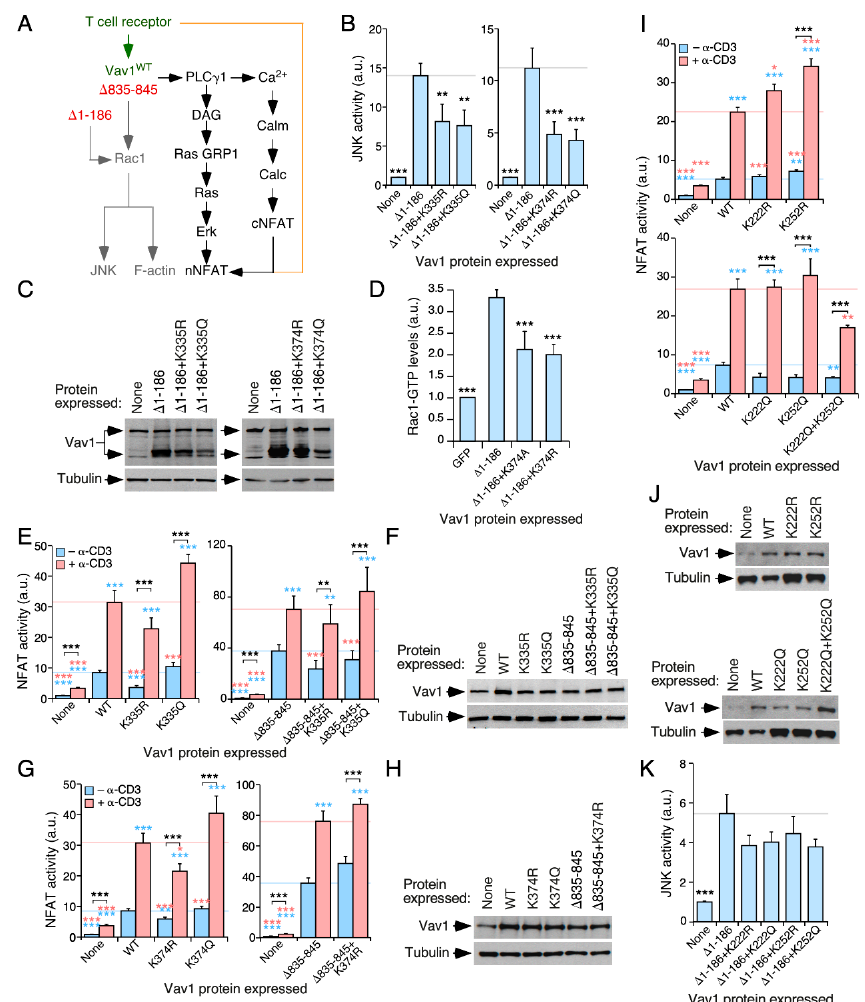
Figure 3. The acetylation of DH domain-localized lysine residues modifies Vav1 signaling outputs. ( A ) Schematic representation of the Vav1-dependent pathways that have been characterized in T cells. The Rac1-dependent pathway directly stimulated by the catalytic activity of Vav1 is shown in gray. The Vav1 adaptor-like pathway involved in the activation of nuclear factor of activated T cells (NFAT) is shown in black. Synergies established with parallel, TCR/CD3-triggered pathways are shown in brown. The wild-type (WT) and constitutively active versions of Vav1 used in this study are shown in green and red, respectively. DAG, diacylglycerol; GRP, GDP-releasing factor; Calm, calmodulin; Calc, calcineurin; cNFAT, cytosolic NFAT; nNFAT, nuclear NFAT. ( B ) Levels of stimulation of c-Jun N-terminal kinase (JNK) triggered by the indicated Vav1 proteins in nonstimulated Jurkat cells. Data represent the mean ± SEM. **, p < 0.01; ***, p < 0.001 using the Mann– Whitney U test of indicated experimental values compared to Vav1 Δ 1 − 186 -expressing cells (n = three independent experiments, each performed in triplicate). ( C ) Representative immunoblots showing the abundance of the ectopic Vav1 proteins and endogenous tubulin α in the experiments shown in B. ( D ) The activation of endogenous Rac1 upon the expression of indicated Vav1 proteins in COS1 cells. ( E , G , I ) Activation levels of NFAT elicited by the indicated Vav1 proteins in nonstimulated and TCR-stimulated Jurkat cells. Data represent the mean ± SEM. Statistical values were obtained using the Mann–Whitney U test. Blue and salmon asterisks indicate the significance level compared with nonstimulated and TCR-stimulated Vav1 WT -expressing cells (left panel) or Vav1 Δ 835 − 845 -expressing cells (right panel), respectively (n = 3 independent experiments, each performed in triplicate). *, p < 0.05; **, p < 0.01; ***, p < 0.001. ( F , H , J ) Representative immunoblots showing the abundance of the